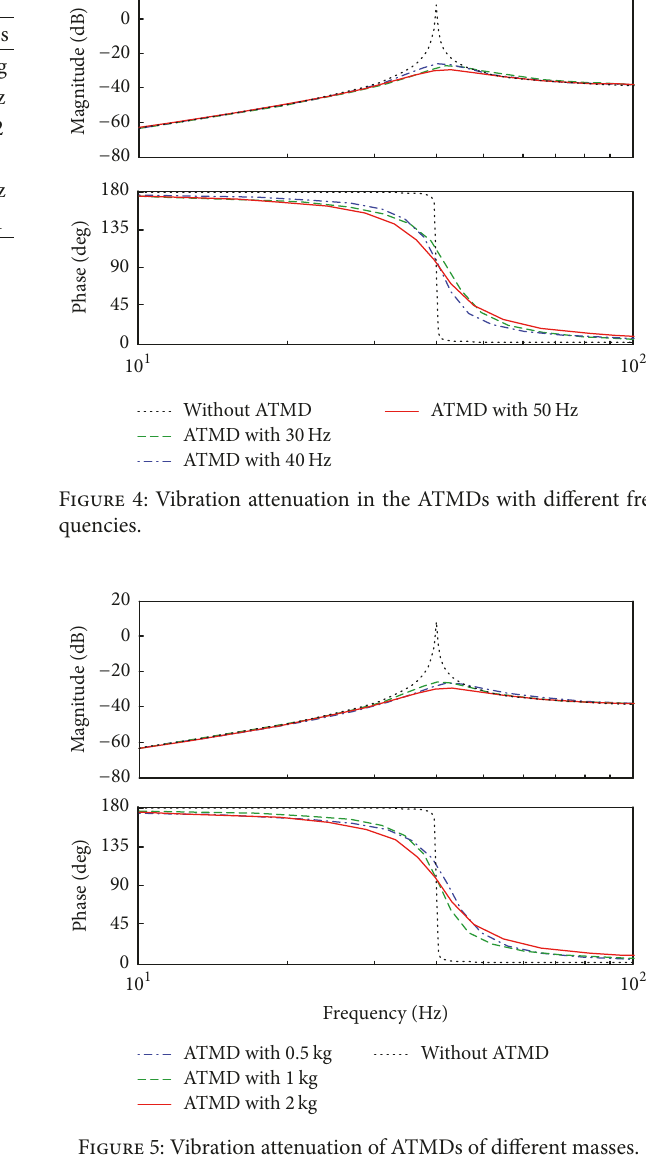
Table 1: Simulation parameter settings.